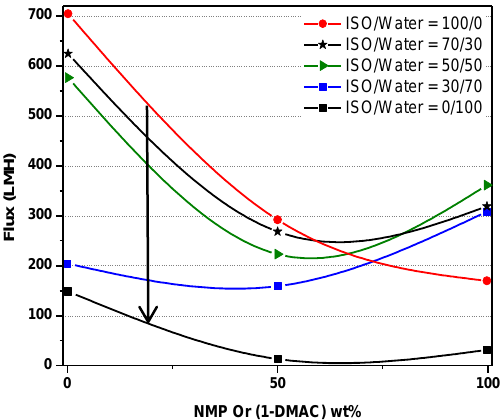
Figure 1. Flux versus solvent concentration for various isopropanol concentrations.